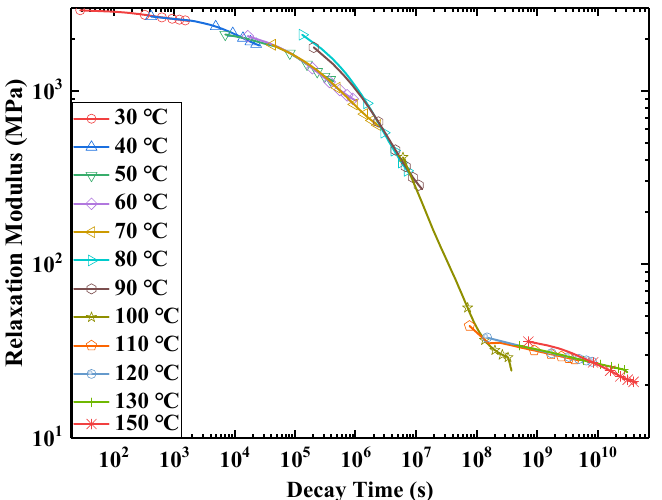
Figure 8. Translational change of the modulus at 30 °C.